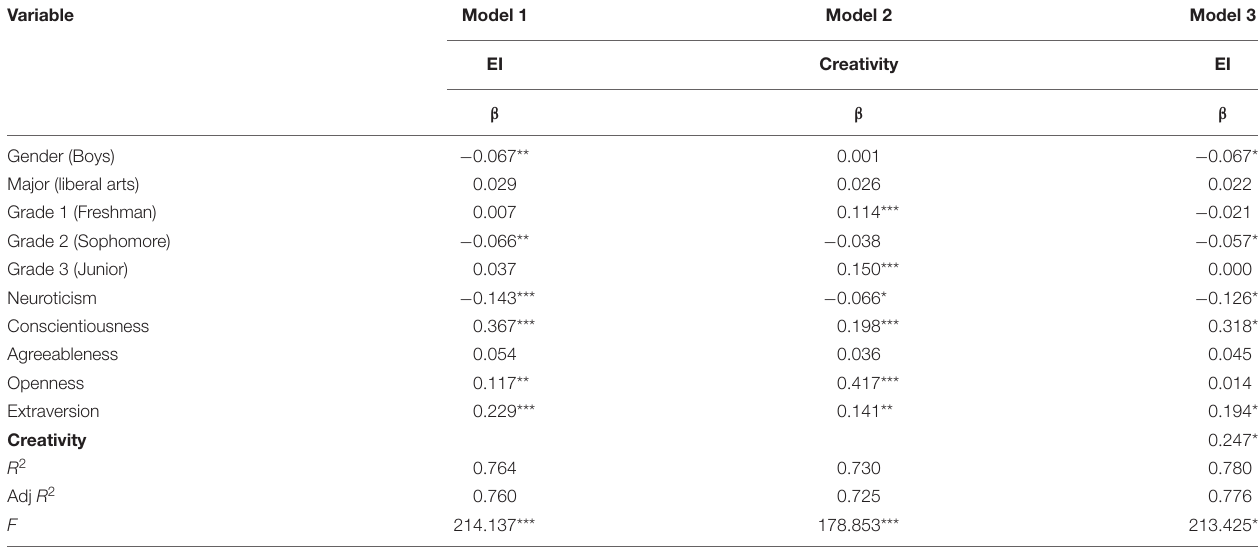
TABLE 2 | Examination of the mediating role of creativity in the influence of personality traits on entrepreneurial